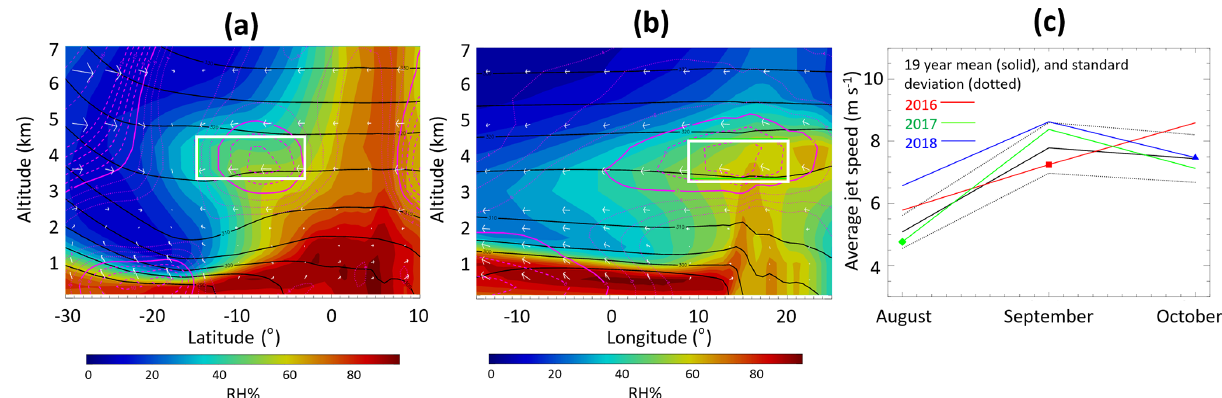
Figure 7. September-mean (a) meridional and (b) zonal cross sections of RH (shading), potential temperature (black contours), and horizontal winds (white barbs), with wind speeds exceeding 7ms − 1 outlined in magenta contours (7ms − 1 – solid; 8 and 9ms − 1 – dashed), at (a) 9.75 ◦ E and (b) 9.75 ◦ S, respectively, averaged over 19 years (2000–2018). (c) Strength of the SAEJ averaged over the volume defined by the white rectangles in panels (a) and (b) . The solid lines represent the individual and 19-year (2000–2018) means; the dashed lines represent the standard deviation during the 19-year